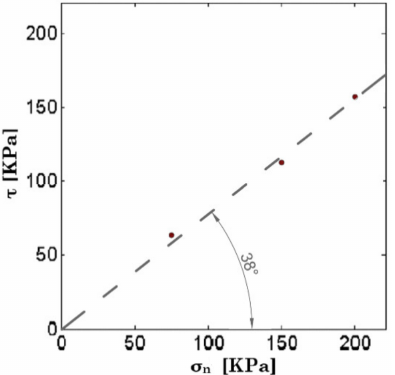
Figure 12. Coupled values [ τ max , σ n ] and interpolating